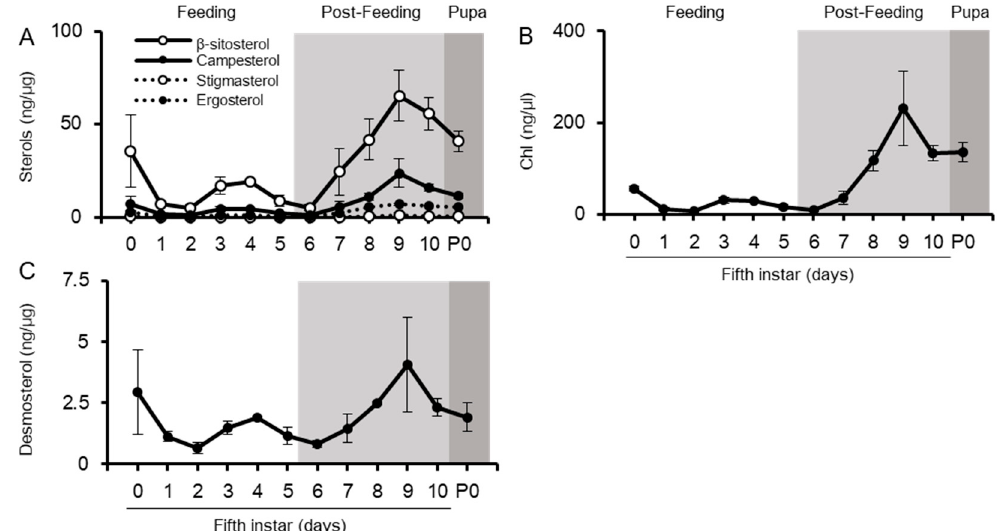
Figure 4. Changes in sterol concentrations in the hemolymph from final instar to pupal periods. The concentrations of dietary sterols ( A ), Chl ( B ), and desmosterol ( C ) were quantified. Values are mean ± s.d. ( n = 3). P0: pupal stage day 0.